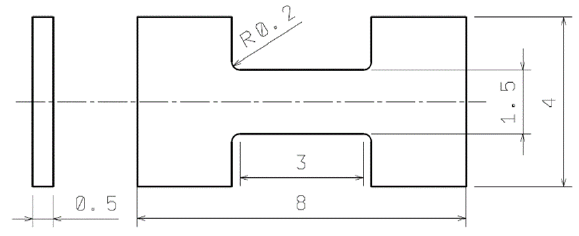
Figure 3. Samples geometry for MTT (mm).